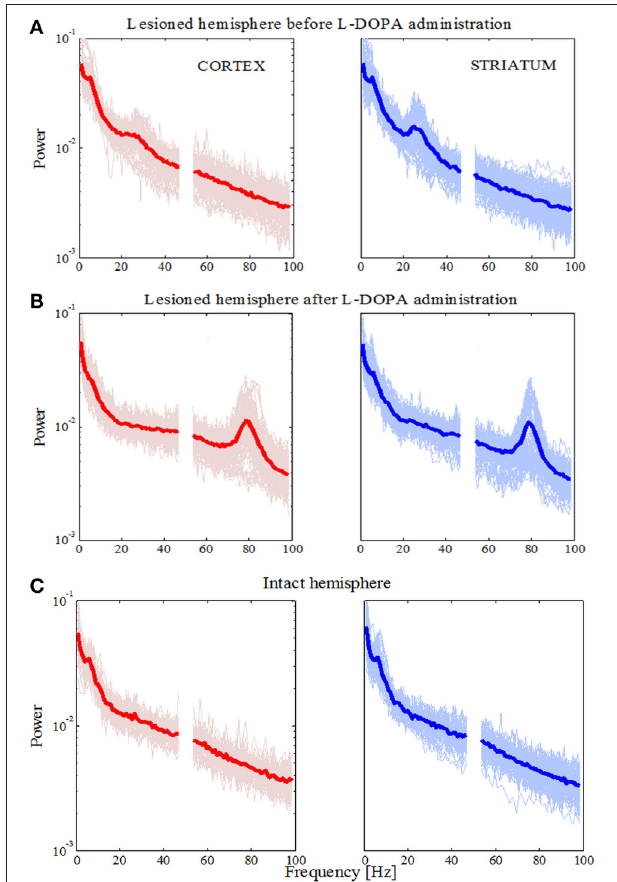
FIGURE 2 | Power spectral densities for the lesioned and intact hemisphere. (A) Power in the lesioned hemisphere before levodopa administration has shown an increase in higher beta frequency band. Traces for single electrodes and their average value (bold red line for the cortex and bold blue line in the striatum) are illustrated. (B) Power in lesioned hemisphere after levodopa administration has shown an increase in higher gamma frequency band (around 80Hz). (C) Power in the intact hemisphere has not shown an increase for any frequency